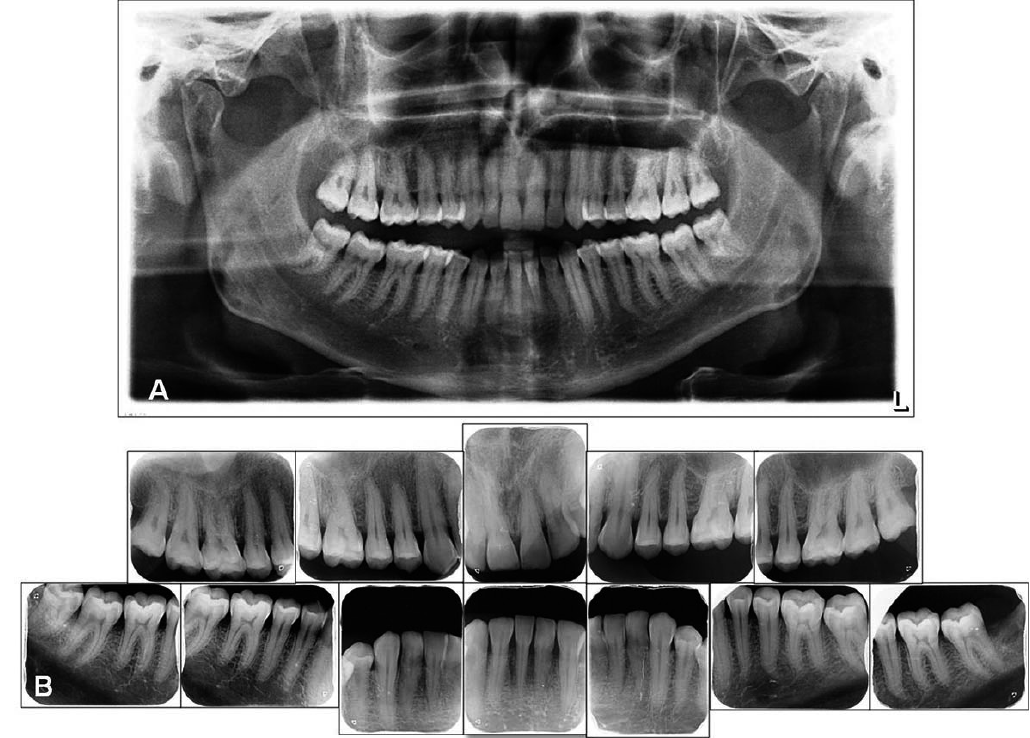
Figure 1- A) Panoramic radiograph of a patient with chronic periodontitis (nO-CP); B) Full mouth periapical radiographs of a patient with chronic periodontitis